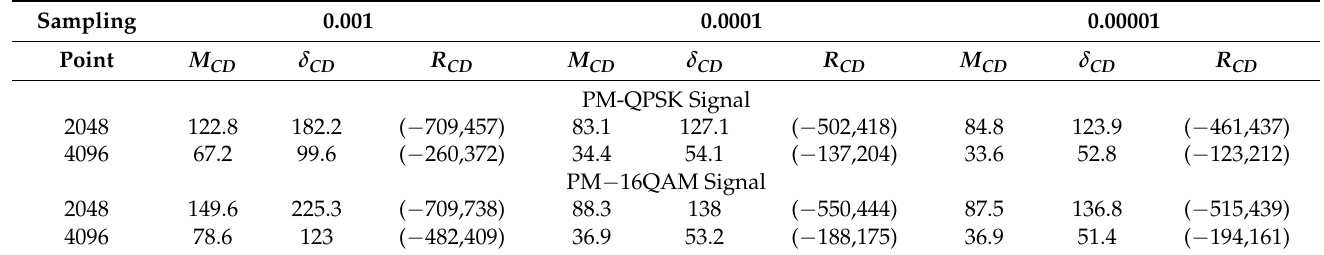
Table 3. CD estimation performance under different sampling points and search interval